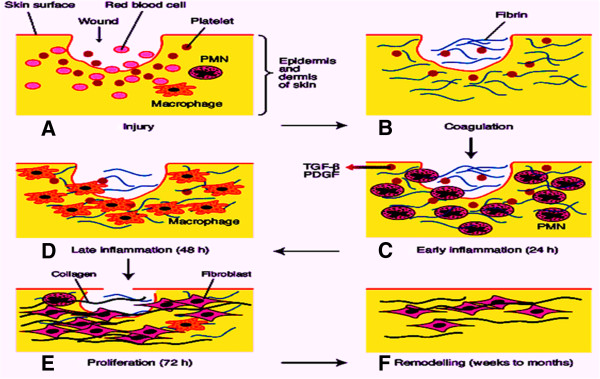
Scheme of different stages of cutaneous wound repair in rats: A, B and C: The first 12- 24 hours after injury is defined by the platelet plug and blood clot formation. Inflammatory cells invade the blood clot triggering acute inflammatory response. Furthermore, blood elements and vasoactive amines extravasate from locally damaged blood vessels within the dermis. Vascular permeability is temporarily increased to allow neutrophils, platelets and plasma proteins to infiltrate the wound. Coagulation then occurs as platelets aggregate with fibrin. D, E and F: After 48–72 h, macrophages replace polymorphonuclear neutrophils as the principal inflammatory cell. Together, polymorphonuclear neutrophils and macrophages remove debris from the wound, release growth factors, and begin to reorganise the extracellular matrix. The proliferation phase begins at about 72 h as fibroblasts, recruited to the wound by growth factors released by inflammatory cells, begin to synthesise collagen. The new tissue is called granulation tissue. Keratinocytes proliferate at the wound edge and migrate down the injured dermis and above the provisional matrix. 1–2 week after injury the wound is completely filled with granulation tissue. Fibroblasts have transformed into myofibroblasts, leading to wound contraction and collagen deposition. The wound is completely covered with a neoepidermis. Modified from Steven R. Beanes et el., 2003.